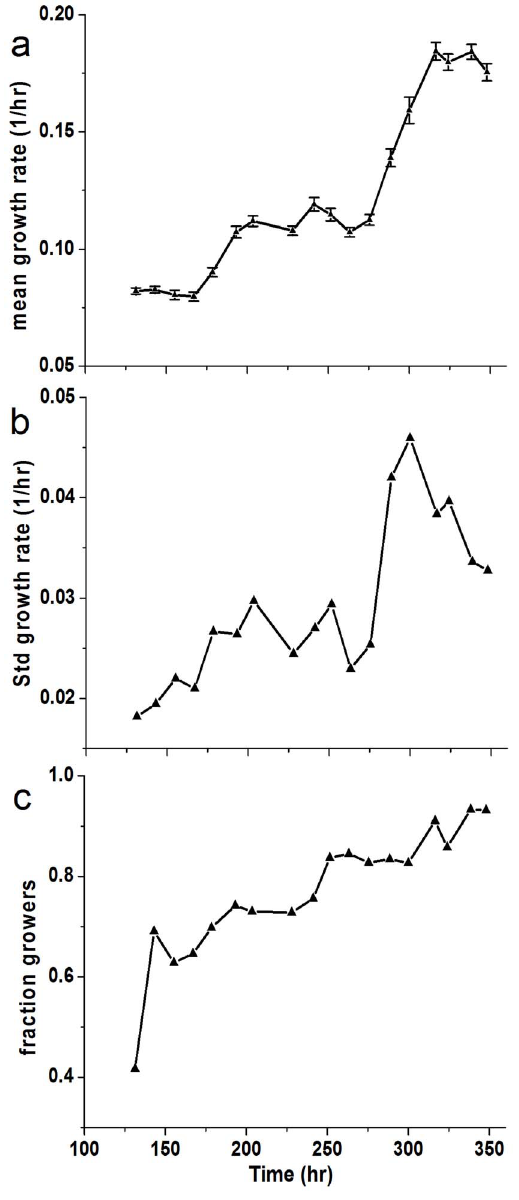
Figure 4. Mean and std of growth-rate and viability. (a) Mean growth-rate extracted from the histograms in Fig. 3. Note the plateaus in the mean growth rate that persist for many generations, followed by decreases and sharp increases. Error bars are the standard error of the mean. (b) The standard deviation of growth-rates computed from the same distributions leading to the mean values presented in (a). (c) Fraction of the population that was measured to be growing exponentially in the same time points as (a). Although the population culture was diluted every 12 hours, the fraction of cells that grew exponentially did not approach 1 for hundreds of